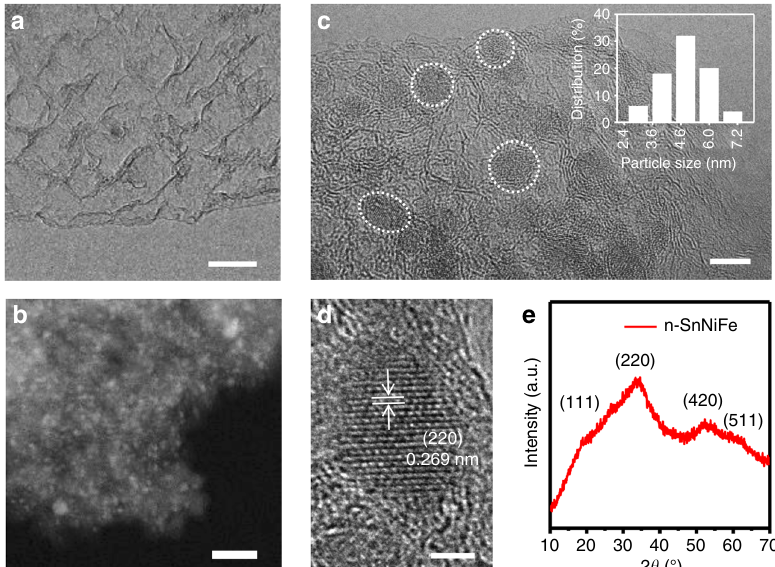
Fig. 2 Morphology and structure characterization of perovskite nanodots. a TEM image of MGF, exhibiting a mesoporous graphene framework. b HAADF-STEM image and c TEM image of n-SnNiFe peroskite electrocatalyst. Inset fi gure in c is the size distribution of n-SnNiFe perovskite nanodots. d The high-resolution TEM image and e XRD patterns of perovskite nanodots spatially con fi ned in mesoporous graphene of n-SnNiFe electrocatalyst. Scale bars, 10 nm ( a ), 5 nm ( b ), 20 nm ( c ), 2 nm ( d